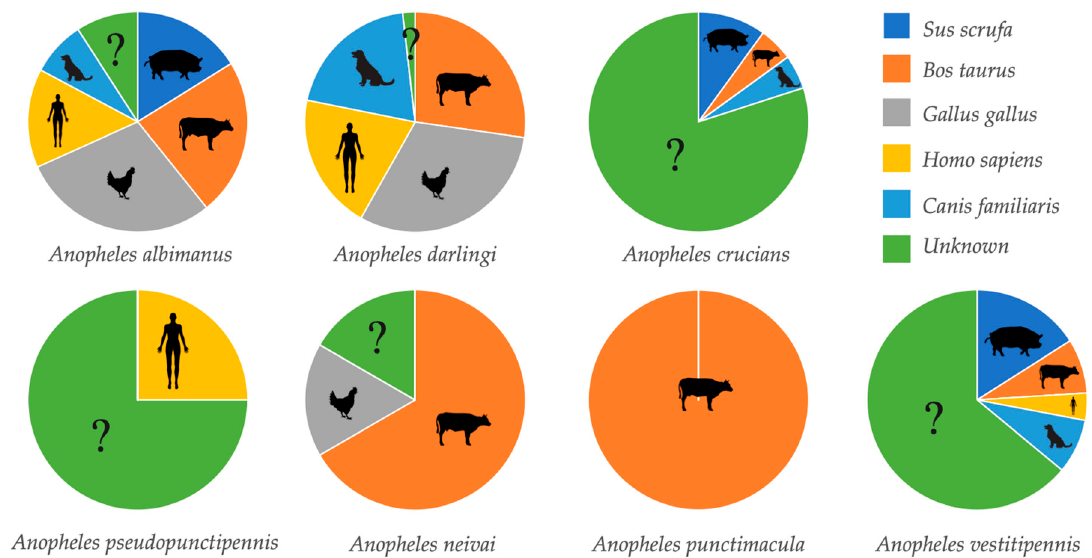
Figure 2. Proportion of blood meal sources by anopheline species.